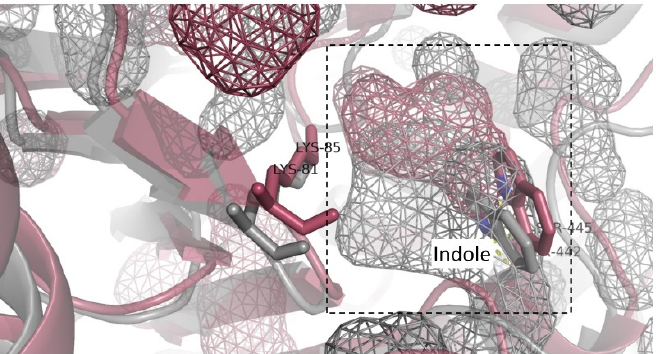
Figure 7. Superimposed homology model of SpH2 (grey) and SpH1 (red) with the docked indole after 1 ns MD simulation. The active site cavity is shown in wireframe (surrounded by dashed-line box). In both cases, an H-bond formed between indole NH and Ser442 and Ser445 in SpH2 and SpH1, respectively. Table 2. Binding affinity of indole and 3-bromoindole to the active site of SpH2 and SpH1.